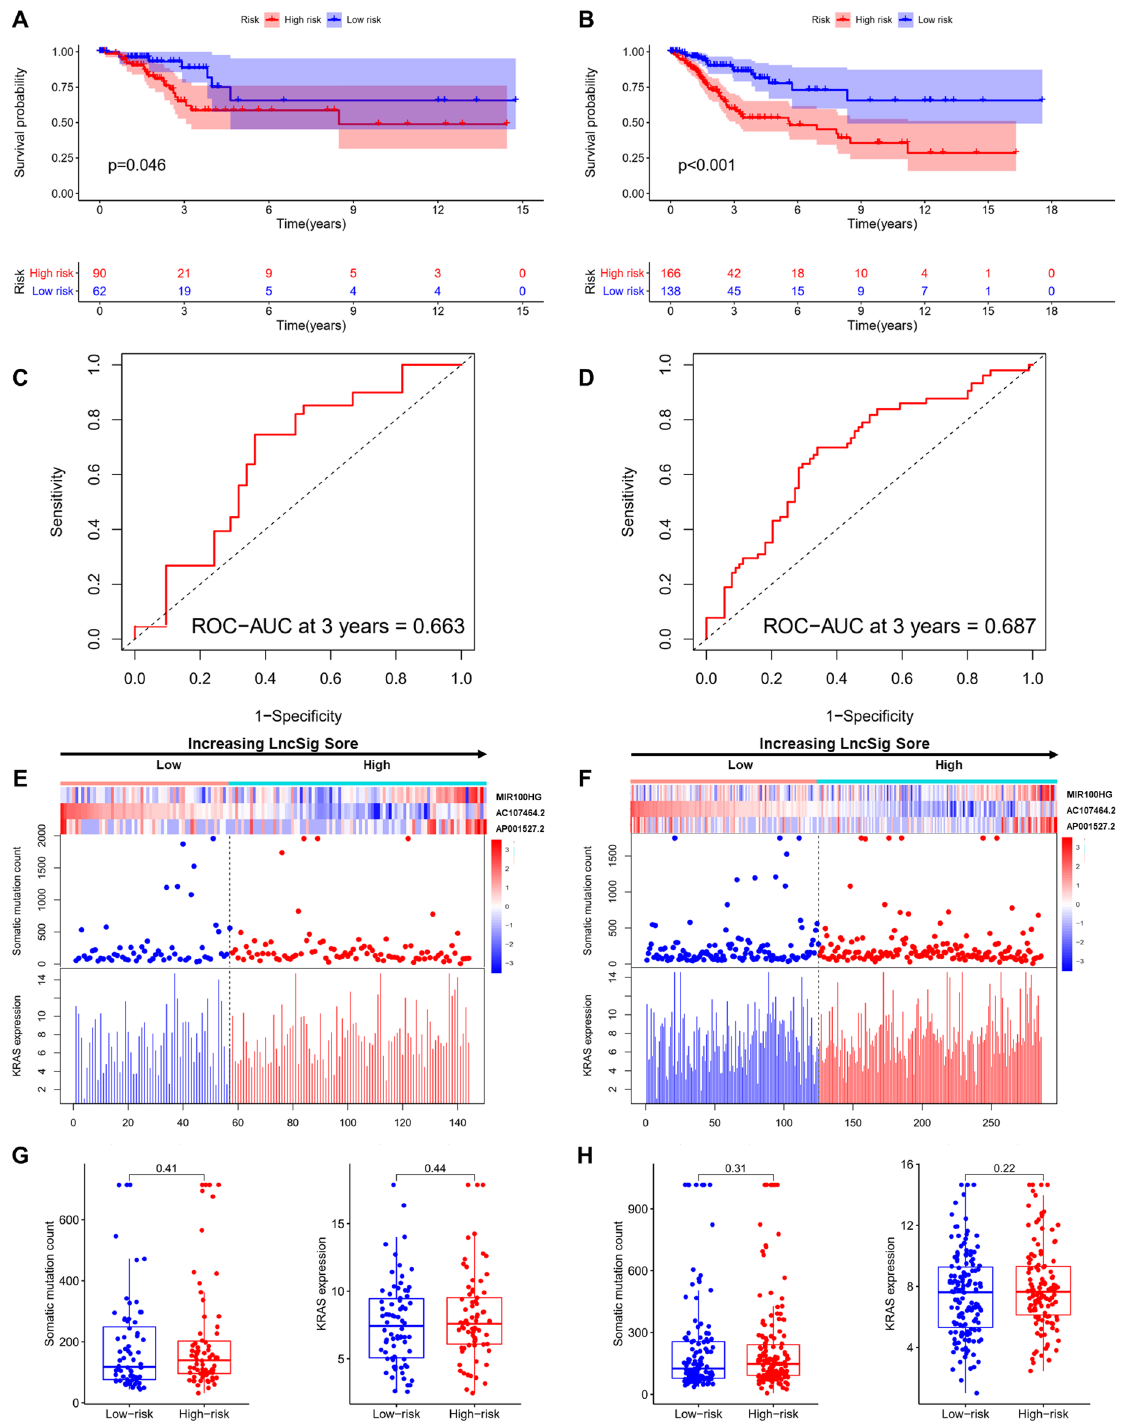
Figure 4. Performance evaluation of the LncSig in the testing and whole set. Kaplan–Meier estimates of overall survival of patients with low or high risk predicted by the LncSig in the testing set ( A ) and whole set ( B ). Time-dependent ROC curves analysis of the LncSig at 3 years in the testing set ( C ) and whole set ( D ). LncRNA expression patterns and the distribution of somatic mutation count distribution and KRAS expression for patients in high- and low-risk groups in the testing set ( E ) and whole set ( F ). The distribution of somatic mutation and KRAS expression in patients of high- and low-risk groups in the testing set ( G ) and whole set ( H